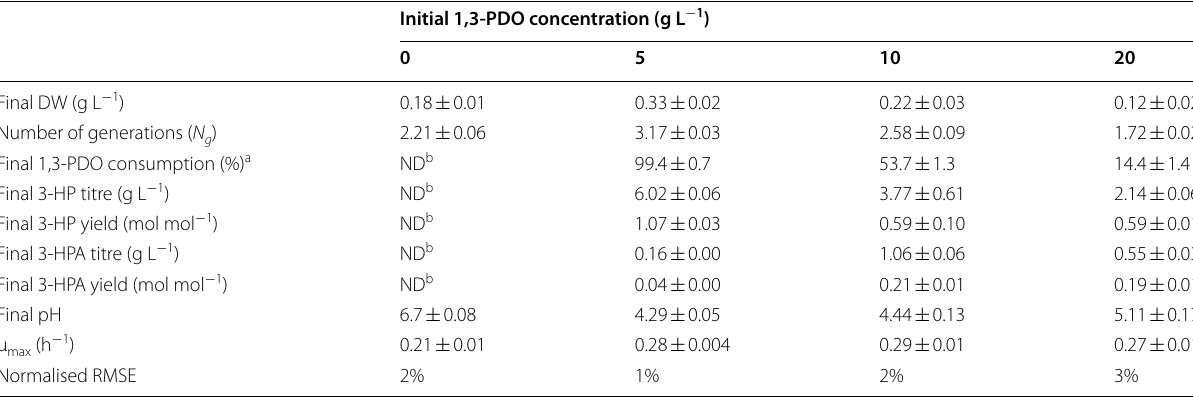
Finals values are calculated at 30 h of culture a Calculated as the percentage of 1,3-PDO initially supplied b Was not calculated because no 1,3-PDO was supplied to the medium